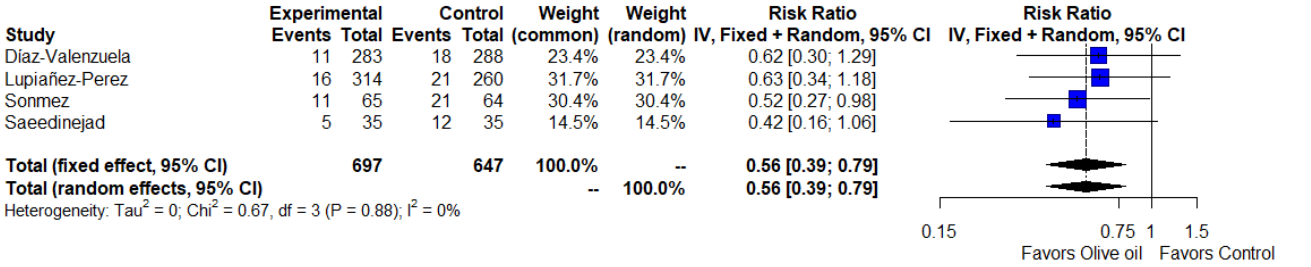
Figure 3. Efficacy analysis (forest plot). The blue squares represent the point estimate of the effect size and sample size. The lines on either side of the box represent a 95% confidence interval (CI). The rhombus represents pooled results [17–20].